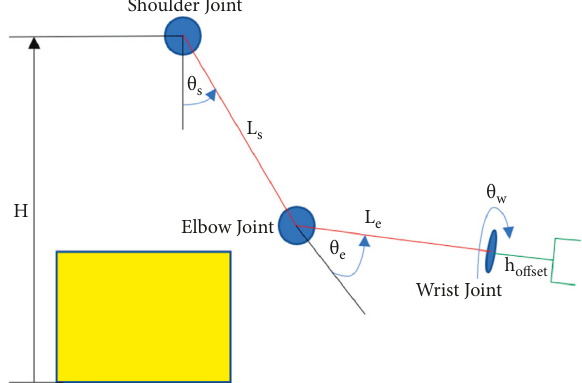
Figure 5: Robot arm schematic for a mobile pPlatform. The initial constraints of the arm workspace are as